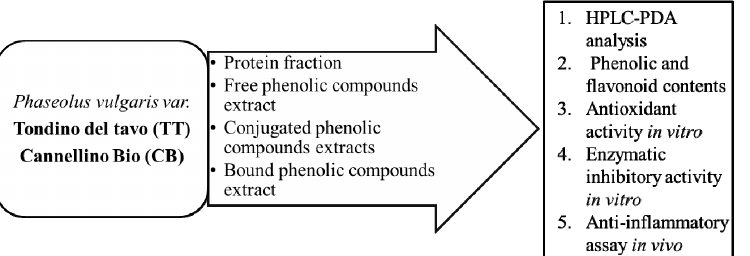
Figure 1. Workflow of comparative analysis for diverse extracts of Phaseolus vulgaris var : TT, Tondino del Tavo; CB, Cannellino Bio.